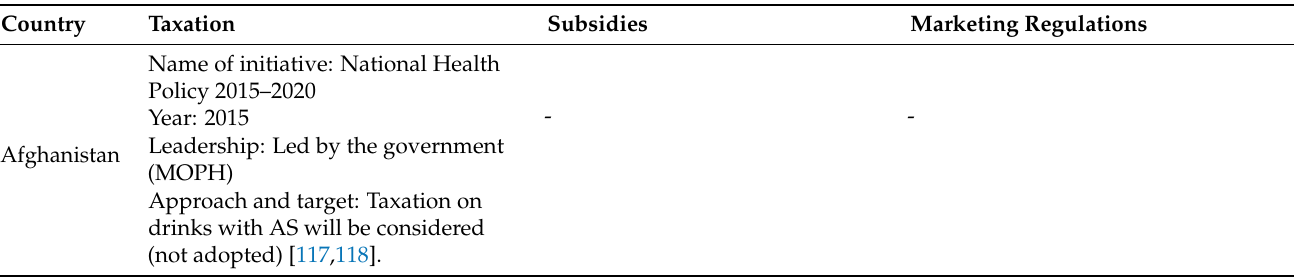
Table 1. Sugar reduction implementation strategies in countries of the EMR: Taxation, subsidies and marketing